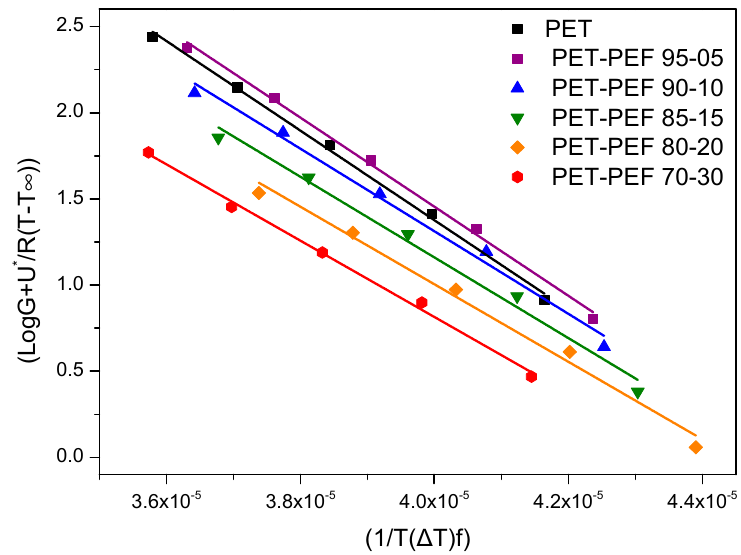
PEF with parameters, U * = 4.57 kcal/mol and T ∞ = 289 K. K g is a nucleation constant and ∆ T denotes the degree of undercooling ( ∆ T = T m0 − T c ); f is a correction factor which is close to unity at high temperatures and is given as f = 2T c / (T m 0 + T c ) [57]. Equation (7) can be also written in its logarithmic form and growth rate G, which should be obtained essentially by the spherulite growth, was calculated by the inverse of crystallization half time (1/ t 1/2 ). Actually, this substitution has been widely used in crystallization studies of polymers [57]. Then, plotting log G + should appear, for each crystallization regime, having a slope equal to K g . Figure 8 gives the plot for the PET-PEF blends. From the slope and the intercept of the corresponding line, the nucleation parameter, K g and ln G 0 can be obtained for each regime. The calculated values for K gII are summarized in Table 1.